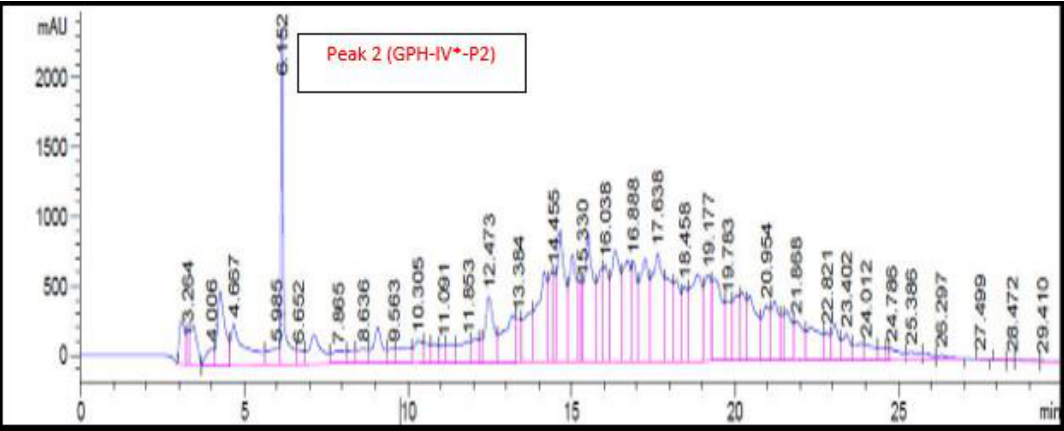
Figure 6. RP-HPLC chromatogram of the bioactive protein fraction (GPH-IV*). The peptides from the bioactive fraction (GPH-IV*) were separated using RP-HPLC on a Zorbax C-18 (4.6 × 250 mm, 5 μm) column. The separation was performed with a linear gradient (from 0–60% for 30 min) at a flow rate of 1 mL/min and monitored at 215 nm. The experiment was repeated 10 times and 15 peaks were collected every 1 min (from 5 to 20 min). The bioactivities were evaluated using a 5 mg/mL concentration of each peak. Peak 2 (GPH-IV*-P2) had the highest bioactivity.